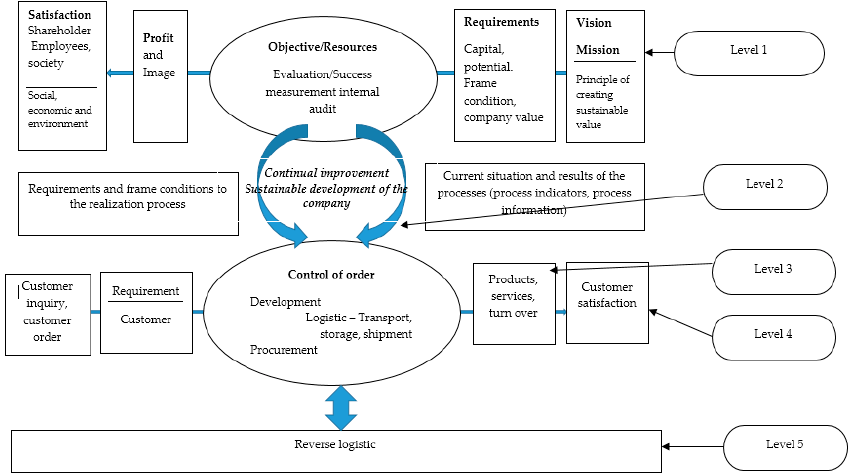
Figure 6. Hierarchical framework for sustainability assessment of manufacturing industry.